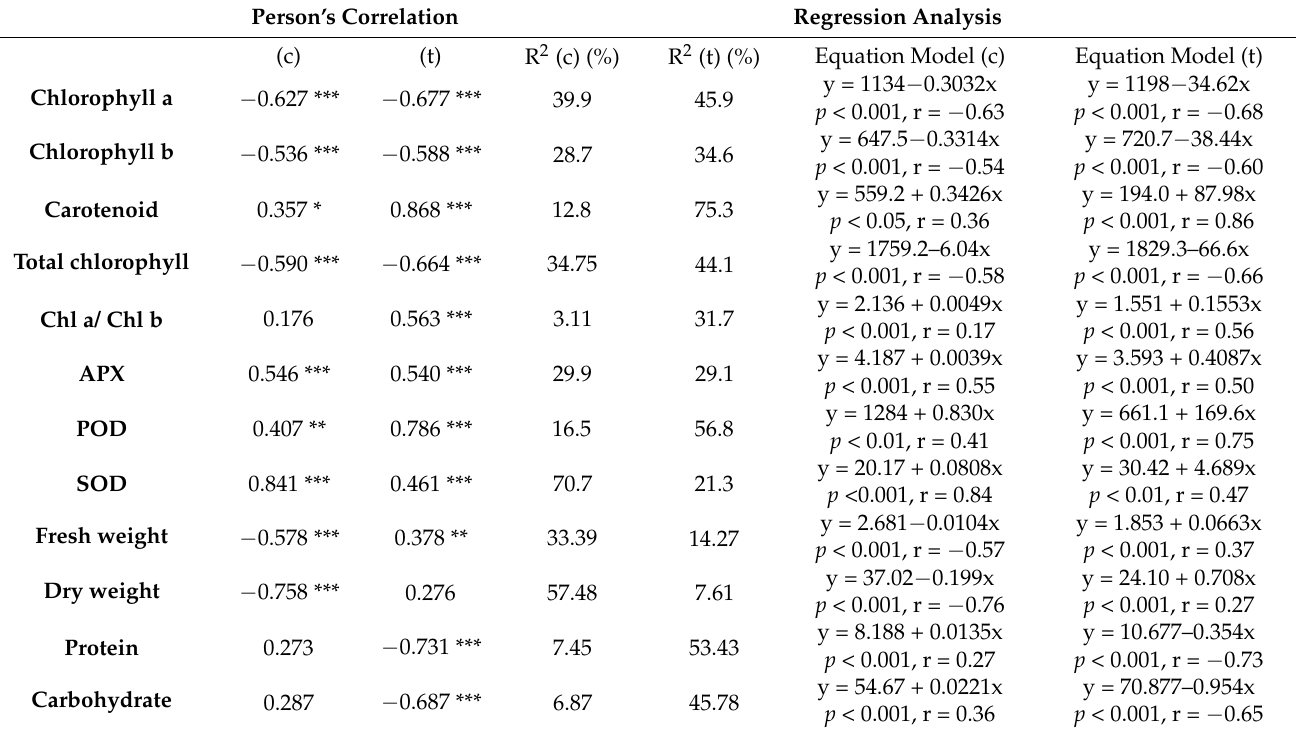
Table 5. Summary statistics, regression analysis, and correlations of the studied parameters under the effects of exposure time (t) and metals concentration (c). *: p < 0.05, **: p < 0.01, ***: p <